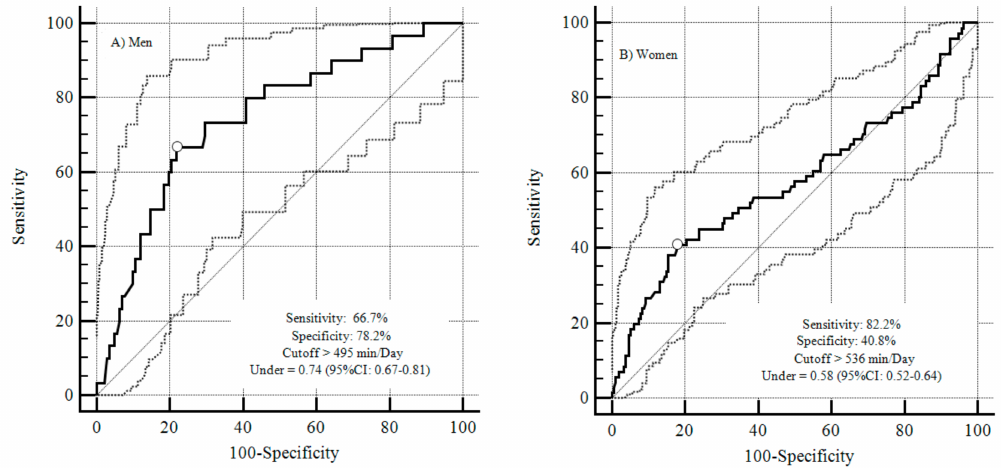
Figure 1. Mean daily time exposed to sedentary behaviour as a discriminant criterion for frailty in the elderly. Solid line: Area under the curve limit; Dotted line: Confidence interval of the area under the curve. ( A ) Men; ( B ) Women.